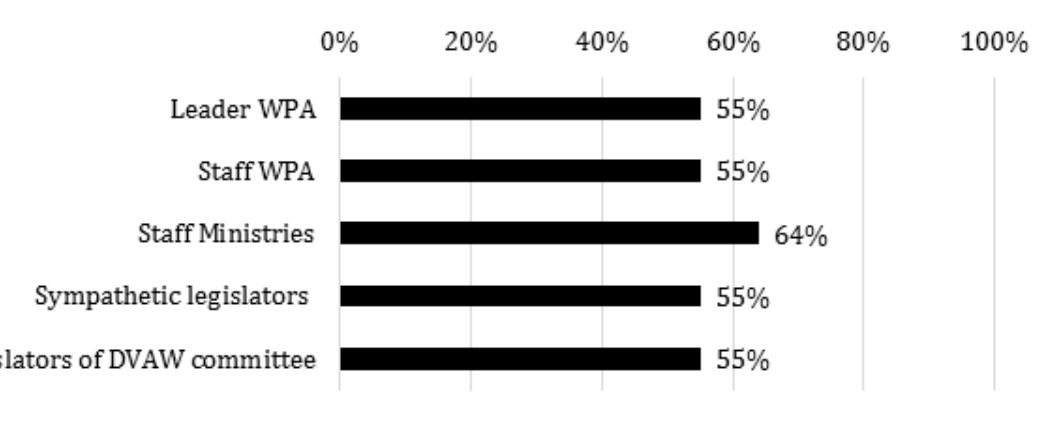
Figure 4: Mechanisms used to in(cid:976)luence the political sphere in Uruguay